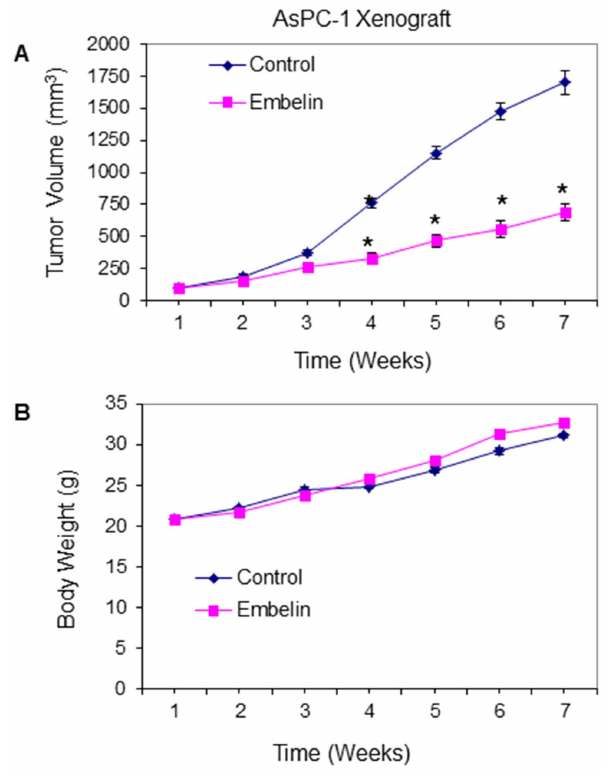
Figure 3. Embelin inhibits the growth of AsPC-1 tumors xenografted in Balb C Nude mice. AsPC-1 cells (2 6 10 6 cells mixed with Matrigel, 50:50 ratio) were subcutaneously implanted into the flanks of Balb C nude mice. Tumor bearing mice were treated with embelin (0 or 40 mg/kg body weight) through gavage (Monday to Friday, once daily) for 6 weeks. Tumor volume (A) and body weight of mice (B) were recorded weekly. Data represent the mean 6 S.D. *=significantly different from control, P , 0.05. AsPC-1 xenografts (Fig. 7 A and B). Treatment of AsPC-1 tumor bearing mice with embelin up-regulated the expression of TRAIL- R1/DR4 and TRAIL-R2/DR5 in tumor tissues compared to untreated control group. These data suggest that embelin can be combined with death receptor ligands (TRAIL or agonistic antibodies) for the treatment of pancreatic cancer.